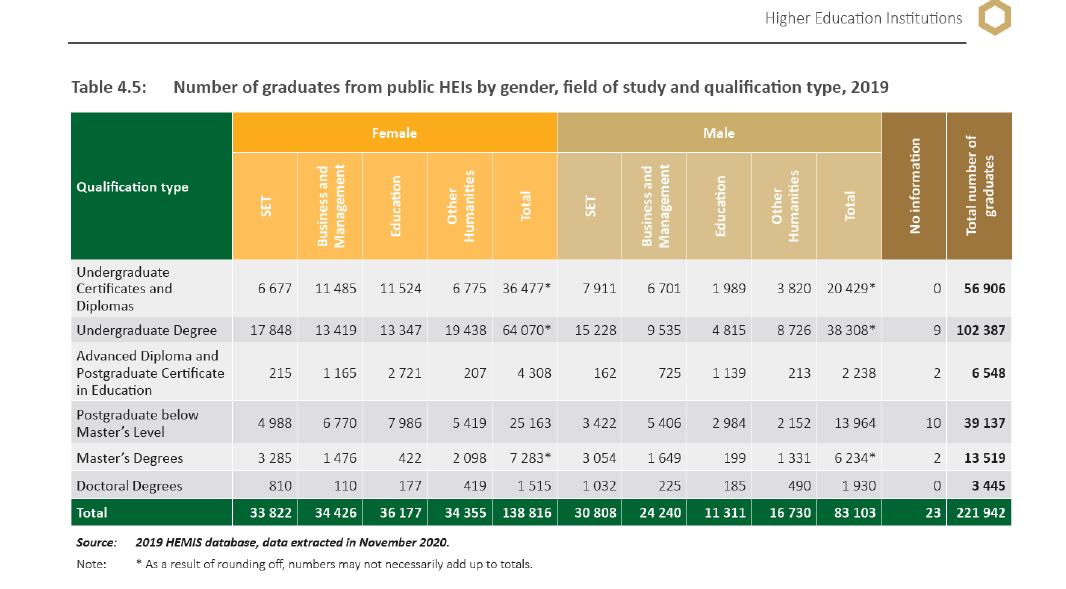
Figure 2 : Example of gender reporting by